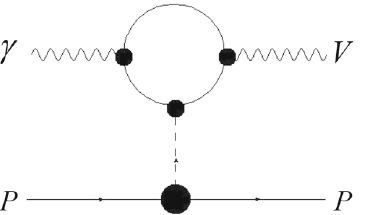
Fig. 2 The schematic diagram of the pomeron exchange model